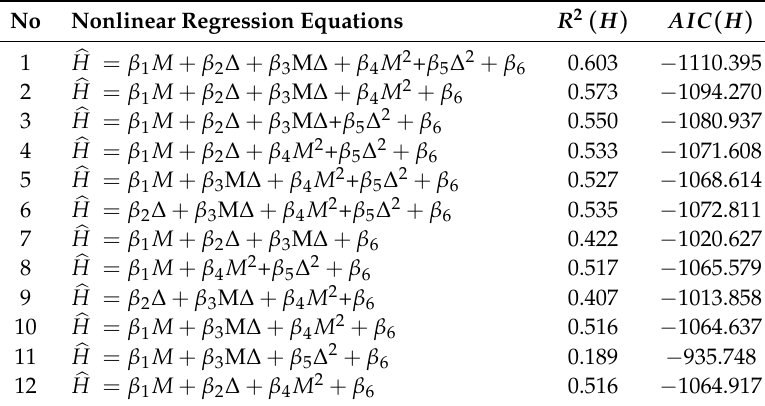
Table 2. Nonlinear regression results.